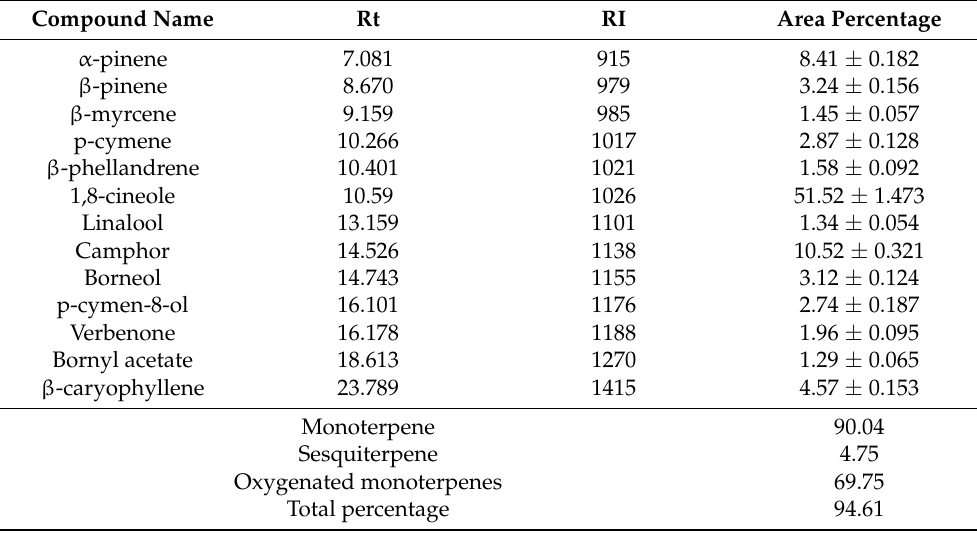
Table 1. Major volatile constituents of rosemary essential oil (REO). All the mentioned volatile constituents have percentages of more than 1%. The quantitative values are expressed as mean ± SEM of six independent leaf samples ( n = 6). Rt: retention time, RI: retention